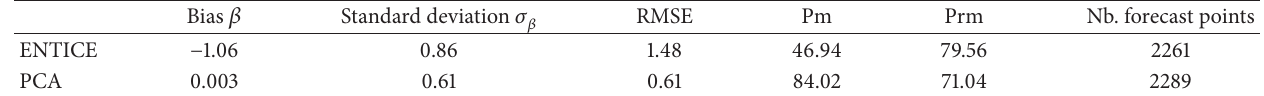
Table 3: Route based validation statistics for the entire UK route.